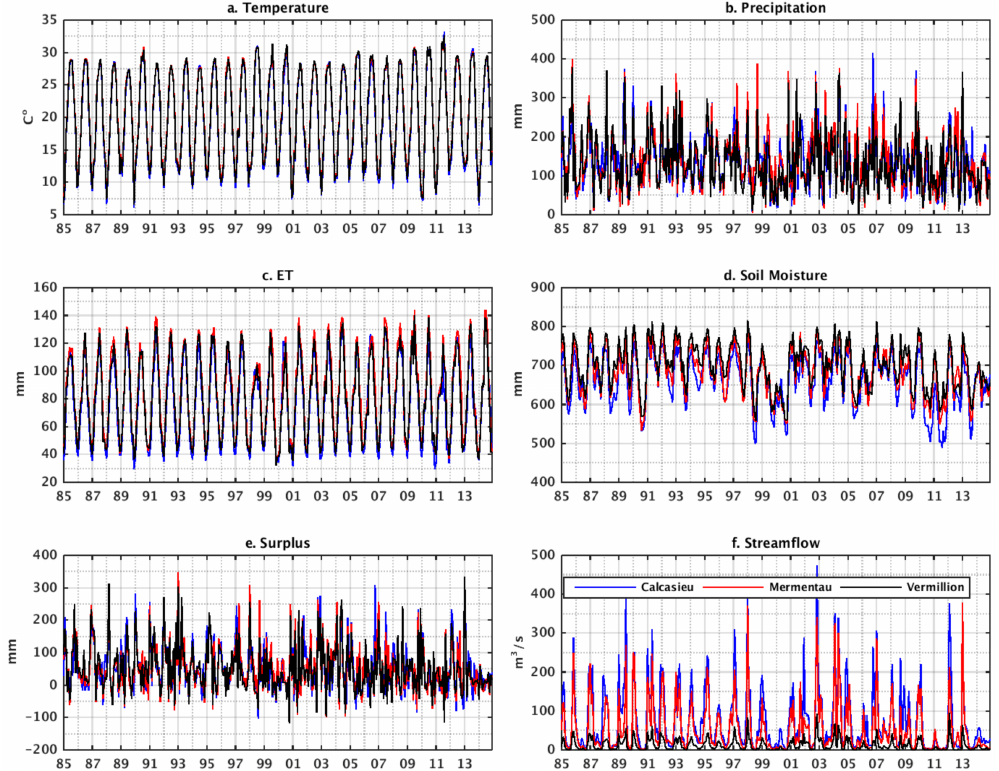
Figure 7. Monthly ( a ) temperature, and ( b ) precipitation from NLDAS-2, and model simulated monthly ( c ) evapotranspiration, ( d ) soil moisture, ( e ) water surplus, and ( f ) streamflow for the Calcasieu (blue), Mermentau (red), and Vermilion